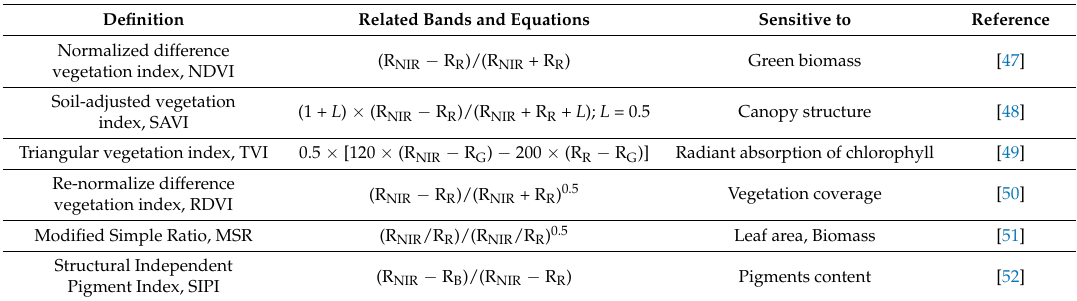
Table 2. The vegetation indices used for classifications in this study, with red band, NIR band, and green band denoted as R R , R NIR , and R G , respectively, for the Planet Satellites. Definition Related Bands and